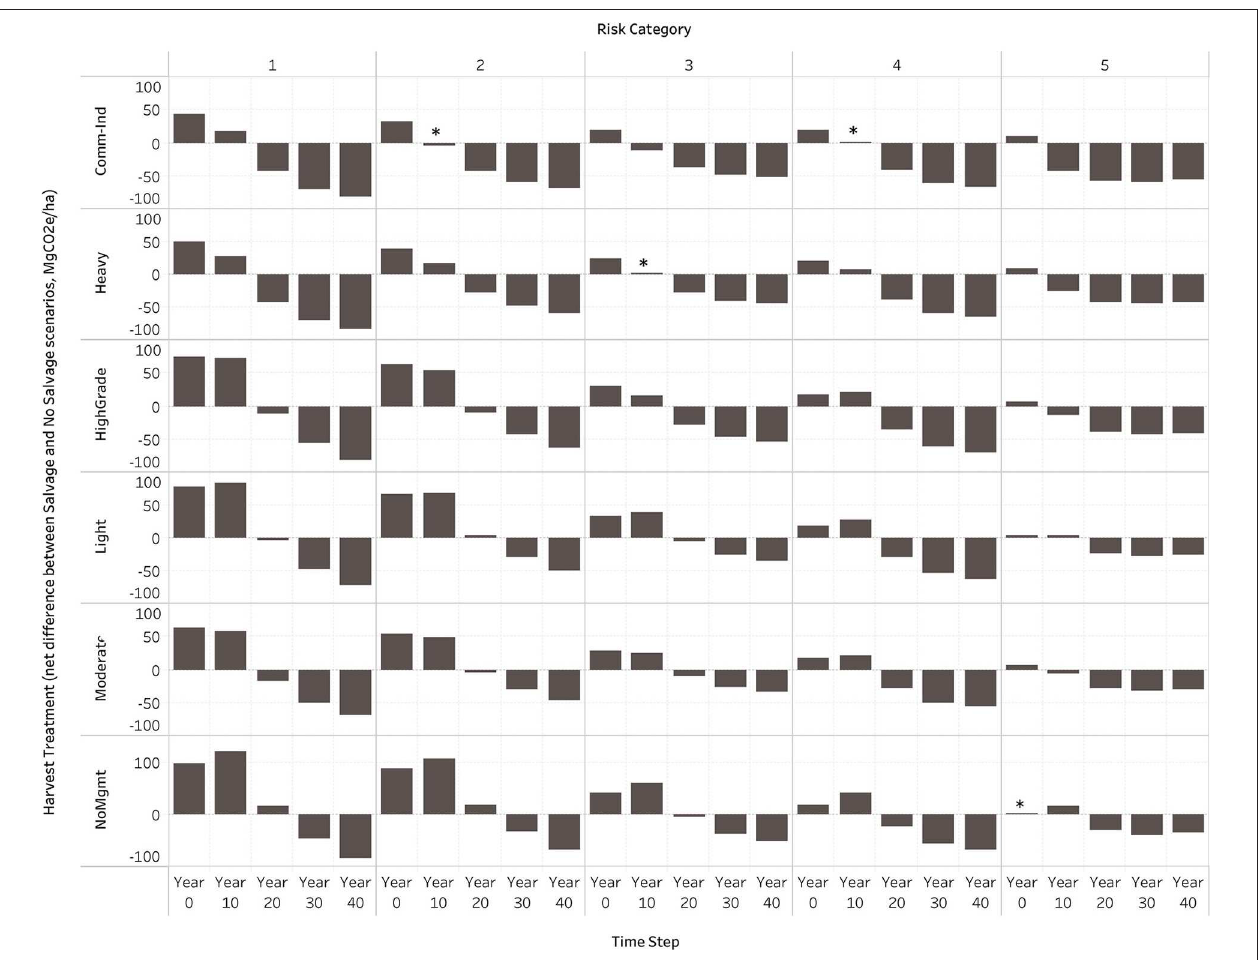
FIGURE 2 | Mean difference between net cumulative emissions of Salvage vs. No Salvage comparisons for each forest management scenario (at 10 years time steps). *Indicates not significantly different from 0 ( p > 0.01). All other comparisons are significantly different from 0 ( p ≤ 0.01).